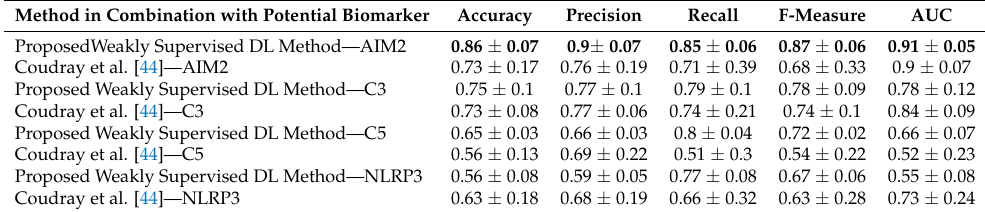
Table 4. Second experiment: 5-fold